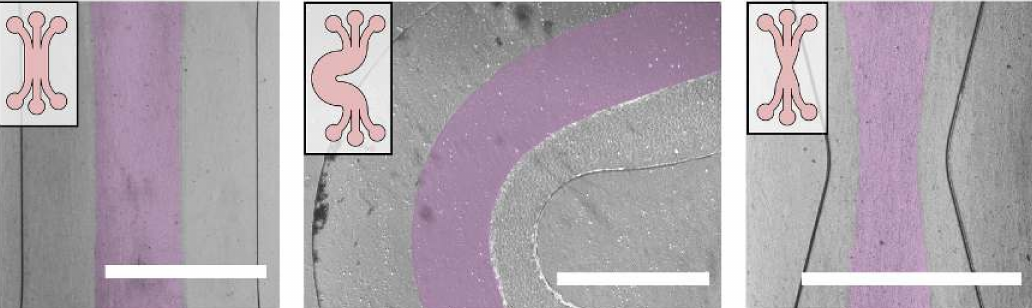
Figure 3. Gel geometries are determined by a combination of device geometry and flow parameters. In all micrographs, the gel-filled region has been artificially colored pink for clarity. Patterning in di ff erent devices yield di ff erent gel geometries that follow the contours of the channels. Insets show device designs and the full panels show the resulting gel geometries. Scale bars are 1